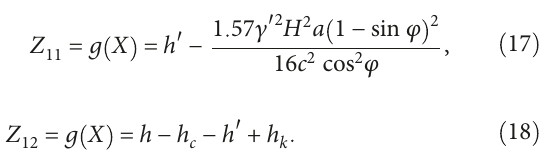
Figure 3: Stress distribution of water-resistant key strata. (a) Distribution diagram of σ diagram of τ xy